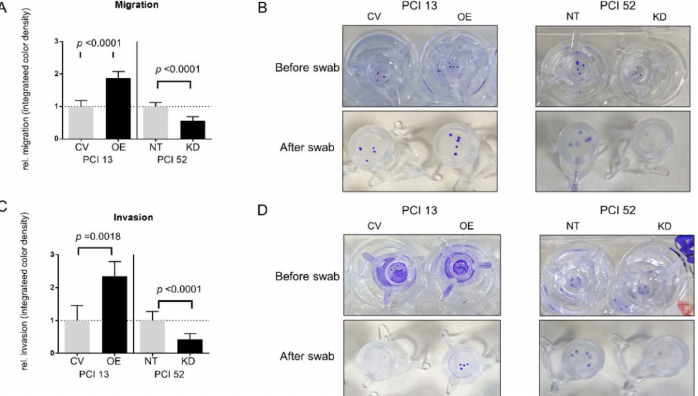
Figure 3. Influence of PD-L1 on migration and invasion. To evaluate the role of PD-L1 in the migration and invasion of HNSCC cell lines along a chemotactic nutrient gradient, a transwell Boyden chamber assay was conducted. ( A , B ) Chemotactic migration of PCI 13 and PCI 52 spheroids with PD-L1 siRNA knockdown (KD) or overexpression (OE). PD-L1 overexpression in PCI 13 (OE) showed a significantly increased transwell migration of spheroids compared to control cells (CV). In contrast, there was a markedly reduced migration after siRNA knockdown (KD) in PCI 52 cells compared to control cells (NT). Accordingly, PD-L1 overexpression led to a significantly increased chemotactic invasion of PCI 13 through a thin layer of Matrigel ® and siRNA knockdown in PCI 52 to a marked reduction ( C , D ). ( B , D ) Photographic documentation of transwell migration assays before and after swabbing nonmigrated / noninvaded cells. The results are expressed as means ± SD, n = 4; unpaired Student’s t